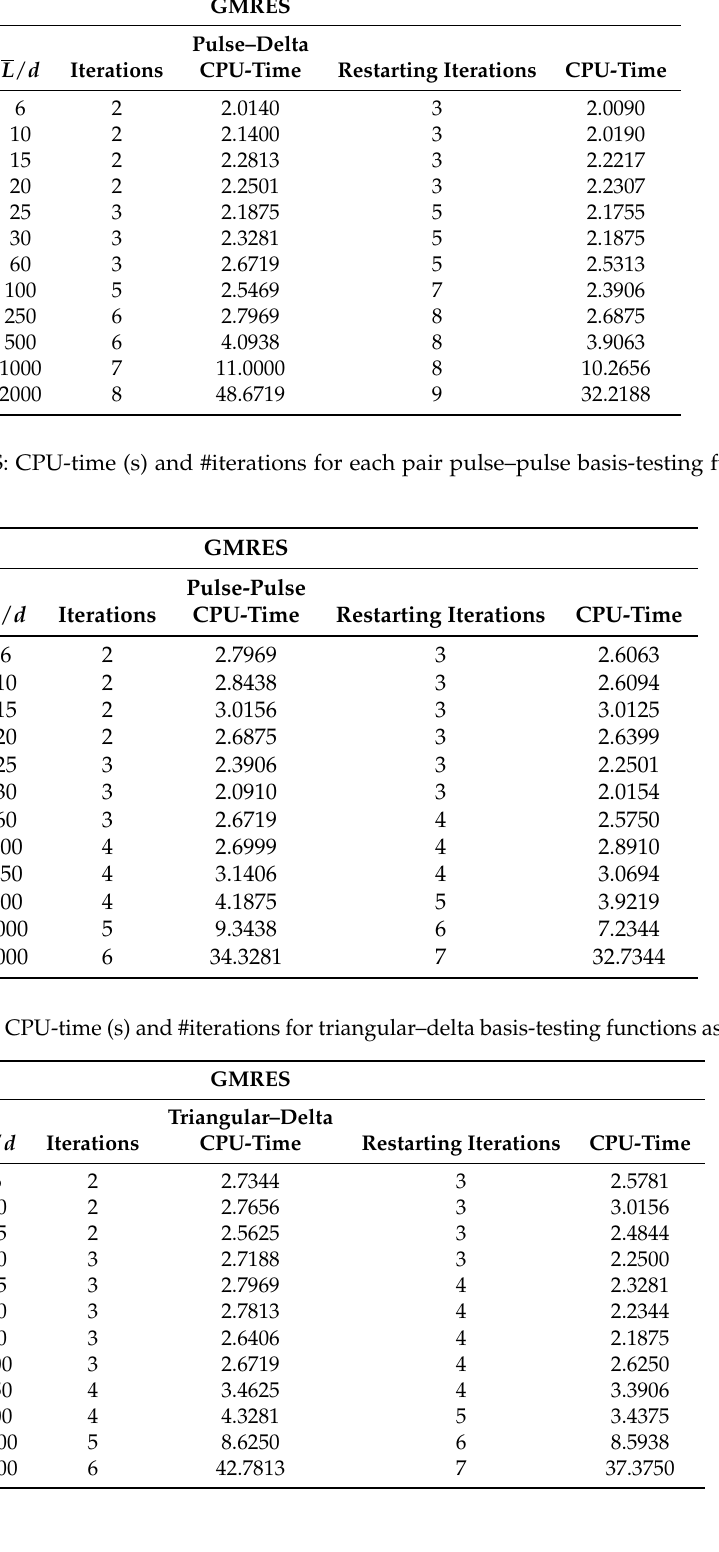
Table 1. GMRES: CPU-time (s) and #iterations for pulse–delta basis-testing functions as L